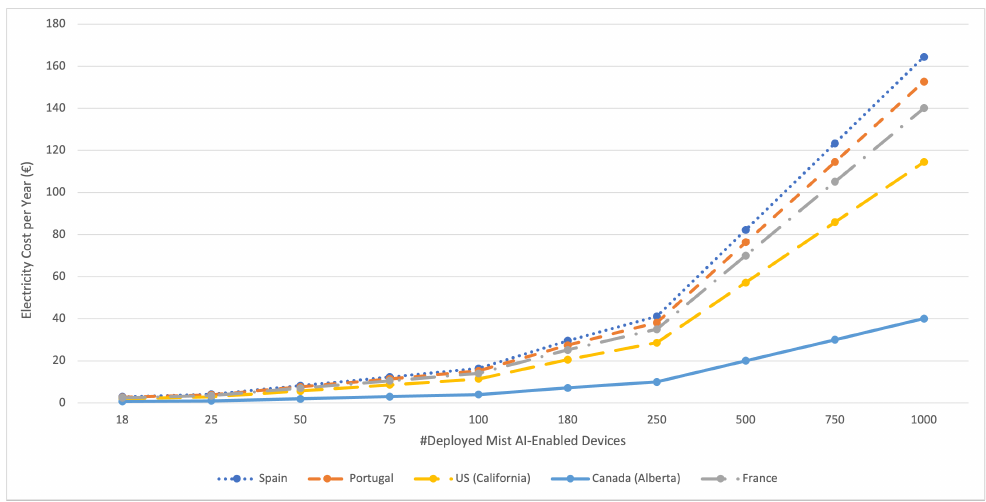
Figure 13. Electricity cost for different number of deployed devices and for different